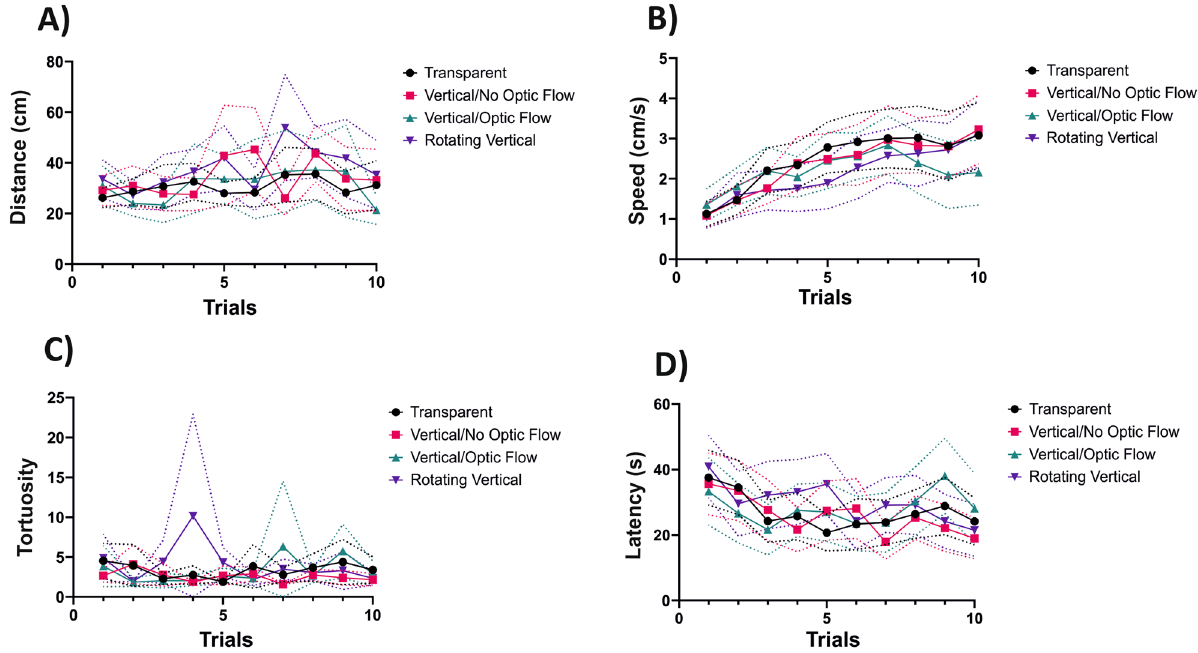
Figure 5. Motor and temporal components of bee trajectories during the acquisition trials. For each background condition, the evolution of ( A ) the distance walked, ( B ) the walking speed, ( C ) the tortuosity and ( D ) the choice latency during training trials is shown. The tortuosity was the ratio between the total distance walked and the straight line connecting the first and the last point of the trajectory during a training trial. Transparent Condition ’ (N = 24), ‘ Vertical Grating—Optic Flow Condition ’ (N = 17), ‘ Vertical Grating—No Optic Flow Condition ’ (N = 17), ‘ Rotating Vertical Grating Condition ’ (N = 17). The dashed lines above and below the curves represent the 95% confidence